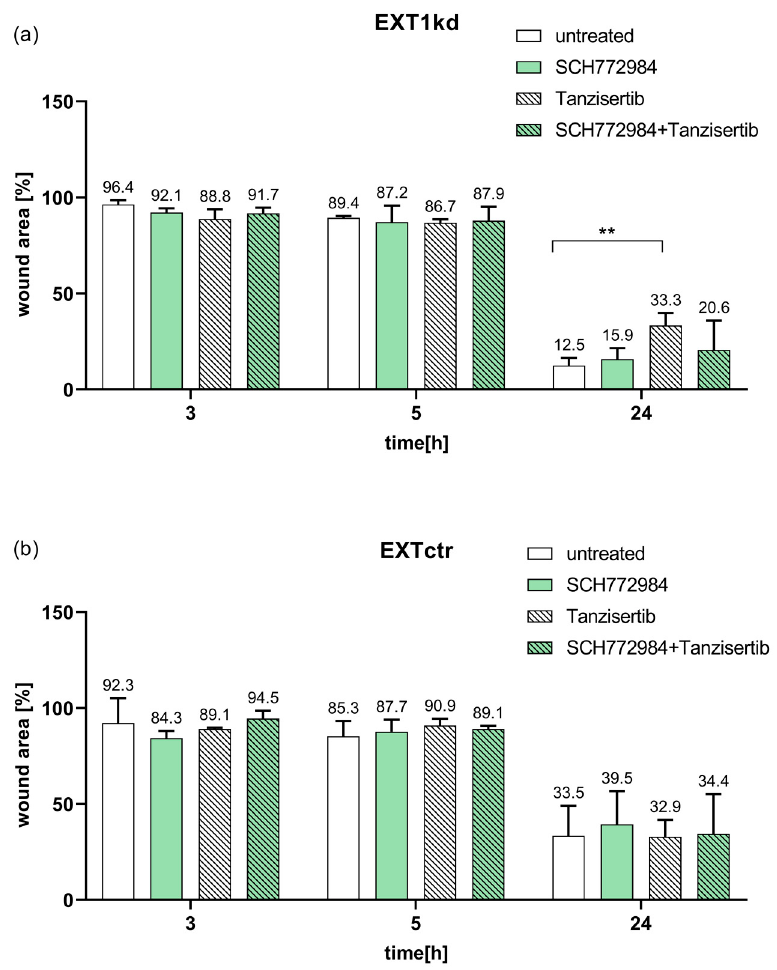
Figure 6. Data of a wound healing assay at 3 h, 5 h, and 24 h of the cell monolayer comparing MV3 EXT1kd and MV3 EXT1ctr cells either untreated or treated with non-toxic concentrations of the JNK inhibitor tanzisertib or ERK inhibitor SCH772984. Data of wound area were indicated in percent, measured in n = 3 for ( a , b ) ( ** = p < 0.01).